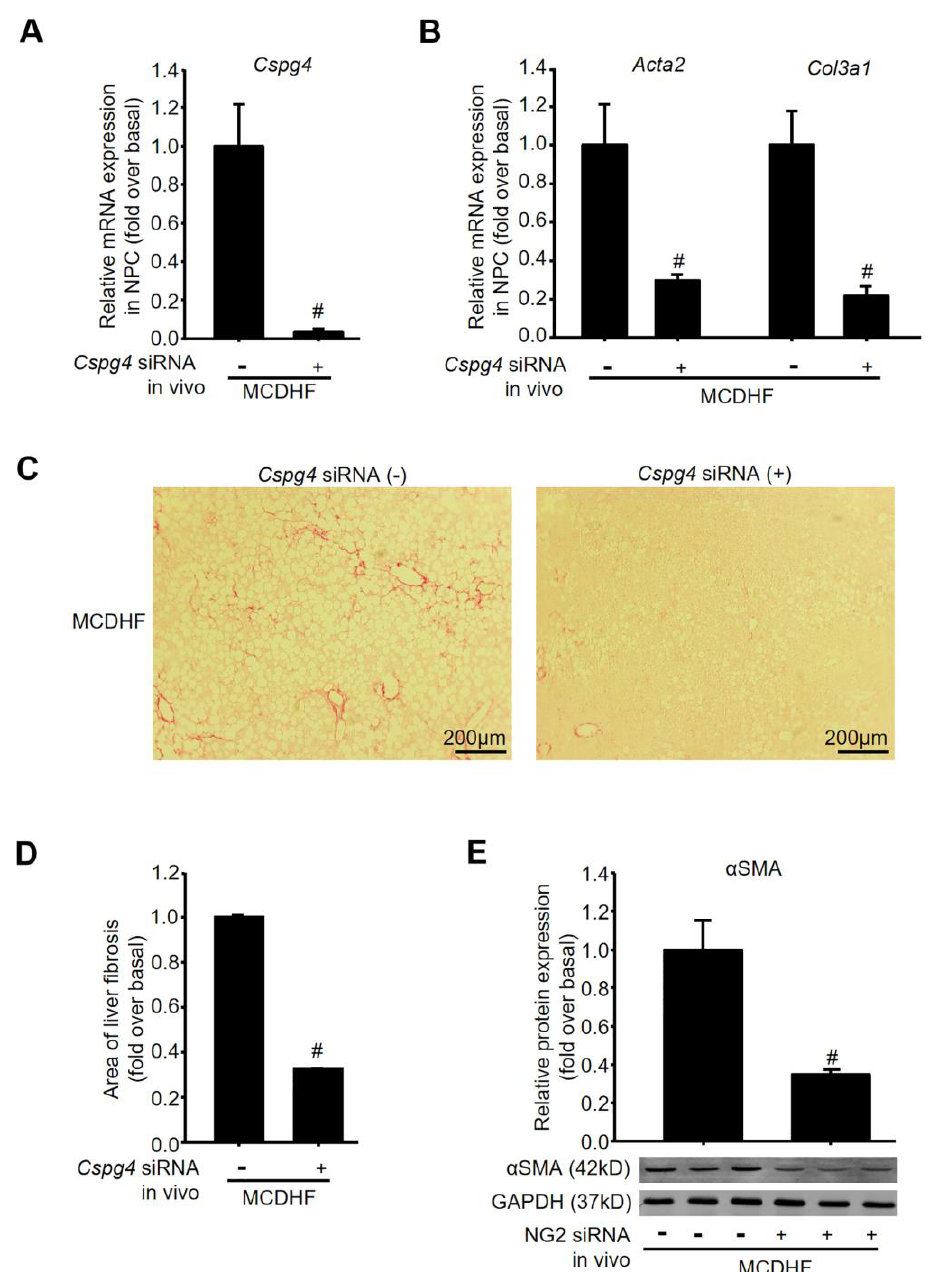
Figure 6. The participation of NG2 in liver fibrosis in vivo. Chemically modified and stable Cspg4 siRNA (1 μ g/g BW) was injected into the mouse tail vein before feeding an MCDHF diet. ( A ) Cspg4 mRNA levels were measured by qRT-PCR with or without the injection of Cspg4 siRNA in liver nonparenchymal cells of MCDHF mice. ( B ) The mRNA expression of fibrotic parameters, including Acta2 and Col3a1 with or without the injection of Cspg4 siRNA in nonparenchymal cells of MCDHF mice. ( C ) Representative images of Sirius Red staining in the absence or presence of Cspg4 siRNA in MCDHF mice. ( D ) Quantitative analysis of fibrotic area with Image-Pro Plus software in Sirius Red-stained liver sections. ( E ) The protein expression of α SMA with or without the injection of Cspg4 siRNA in MCDHF mice. Data are presented as the mean ± SEM. n = 4 per group. # p < 0.05 vs. MCDHF group.